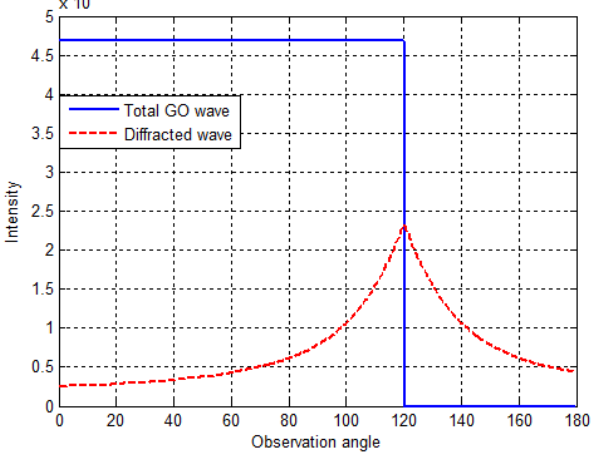
FIGURE 8. The total GO and diffracted magnetic fields.